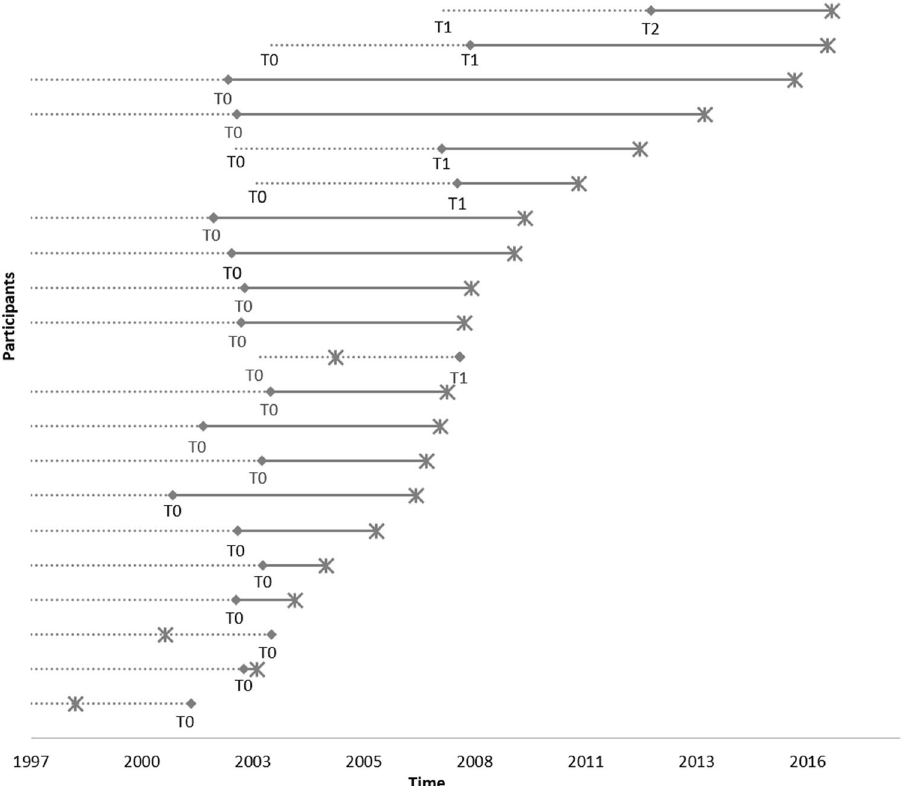
Figure 1. Timeline of MGUS detection and prostate cancer diganosis for study participants with both diagnoses (N = 21). Asterisk: date of PCa diagnosis; diamond: examination visit of MGUS detection; dotted line: time interval of possible MGUS occurrence before MGUS detection; T 0 = date of baseline examination, T 1 = date of 5-year follow-up examination, T 2 = date of 10-year follow-up